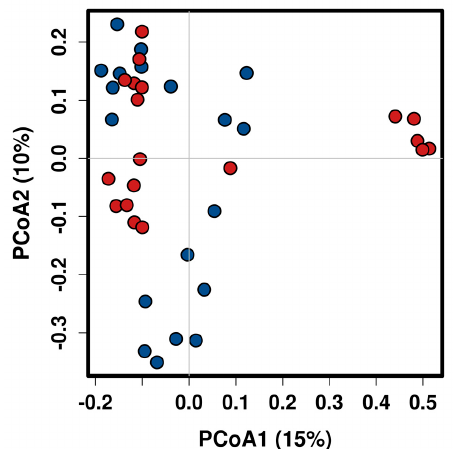
Figure 2. Principal Coordinates Analysis (PCoA) of bacterial communities from primary Sjögren’s syndrome (pSS) patients and healthy controls using Bray-Curtis similarity index at the genus level. Blue dot (pSS patients) and red dot (healthy controls).